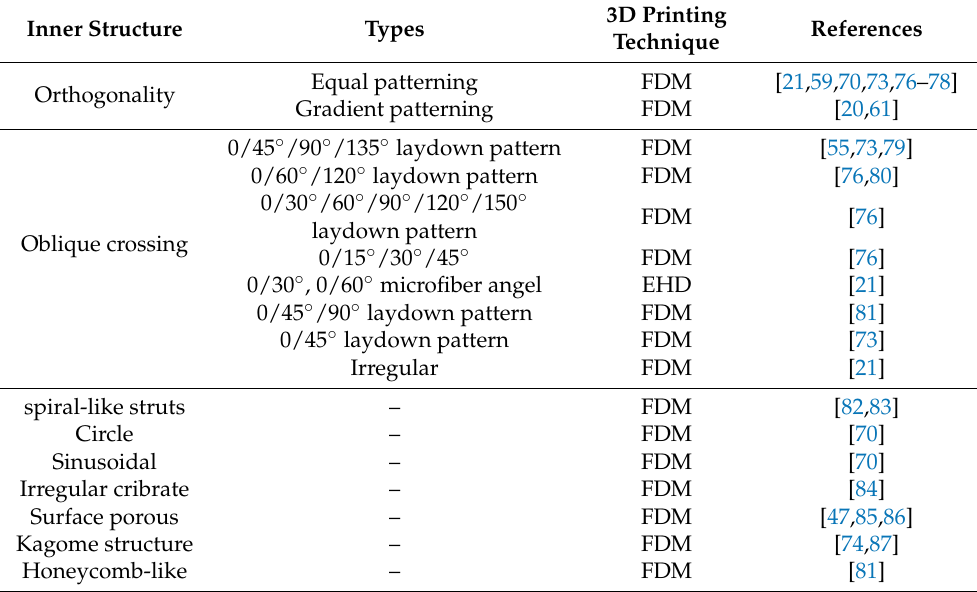
Table 3. The structure design of printed